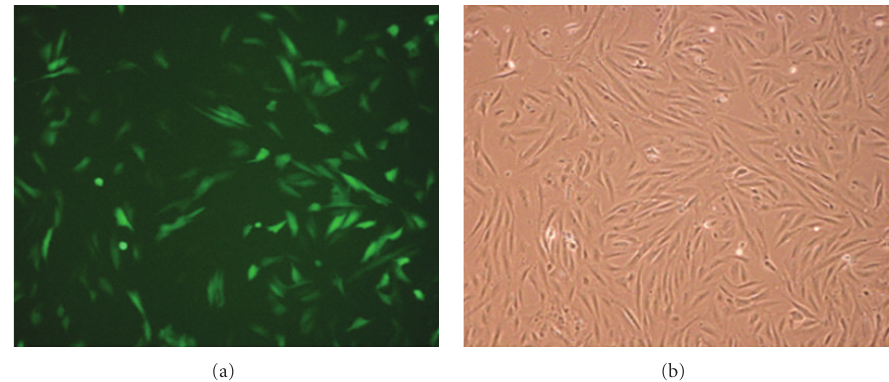
Figure 1: Retrovirus-mediated PGC-1 α overexpression in human skeletal muscle cells. Cultured myoblasts were infected 24–48 h post seeding with 100% medium containing positive control virus pBABE-zsGreen in the presence of 2 μ g/mL polybrene. Cells were incubated in virus-containing medium for 24 h, as described in Section 2. Images were taken 48 h post infection. (a) Fluorescence microscope image. (b) Light microscope image.